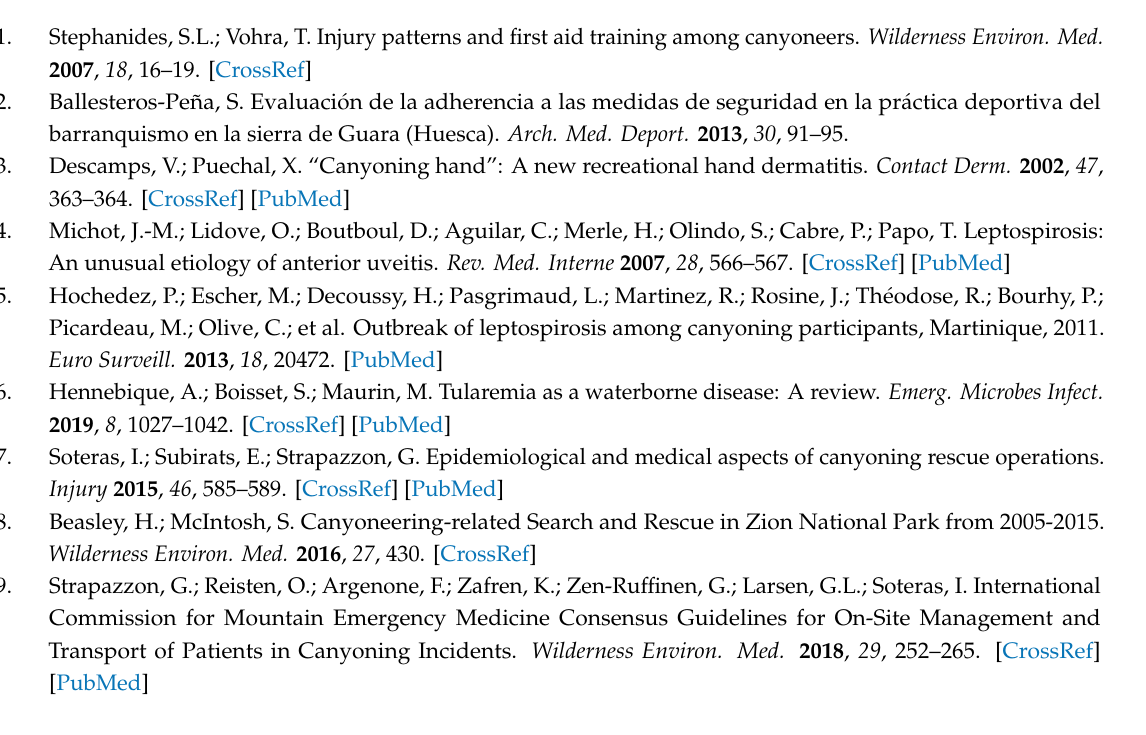
Figure S1: Case Report Form: Canyoning Accidents in Austria; Figure S2: CONSORT Flowchart; Table S1: NACA